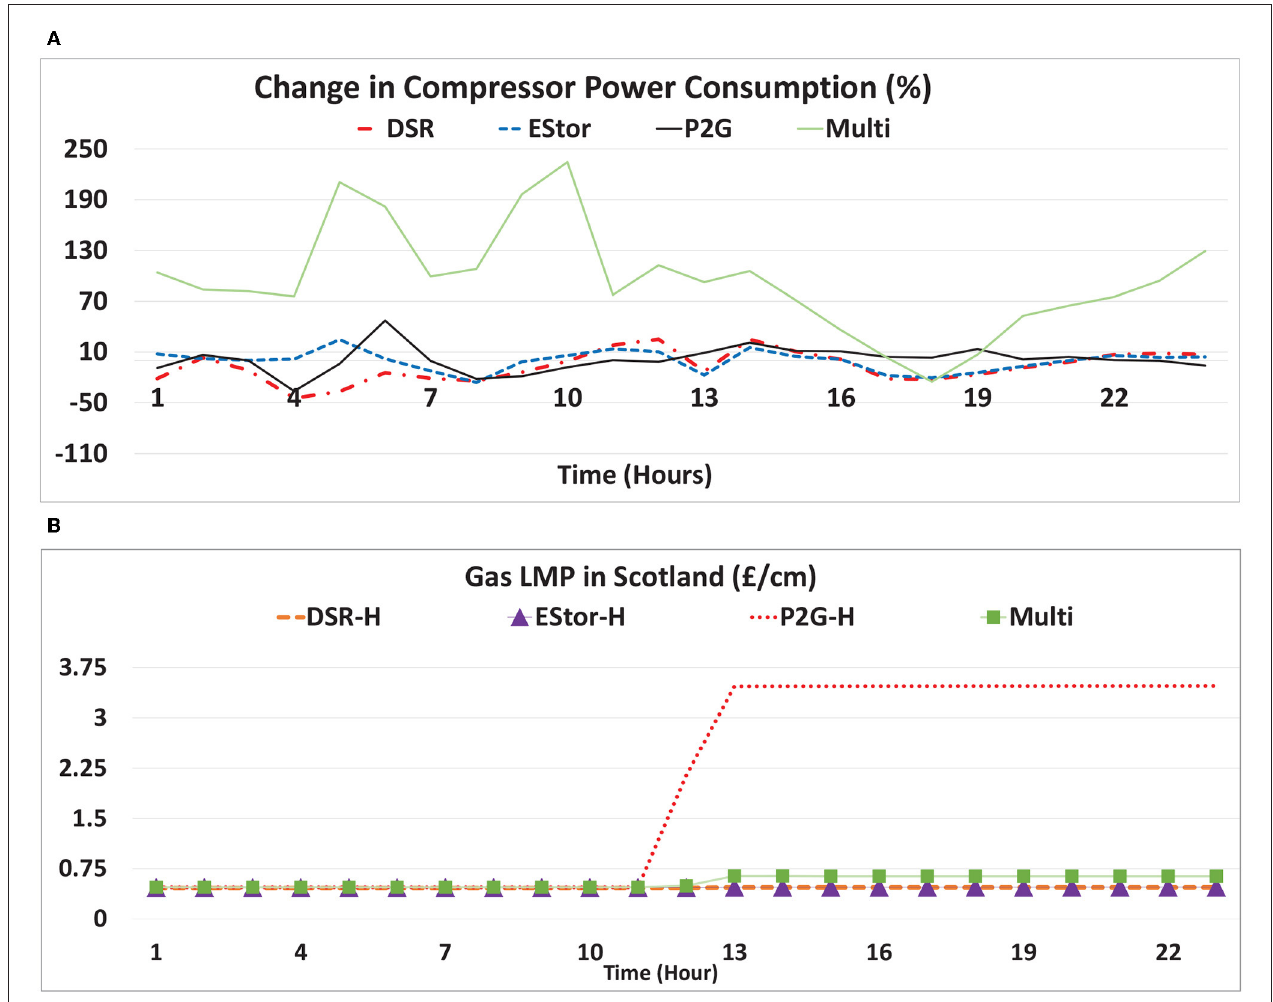
FIGURE 10 | (A) Change in power consumed by the gas compressors on the day of supply interruption compared to the Ref case, and (B) gas LMP in Scotland on the day of supply